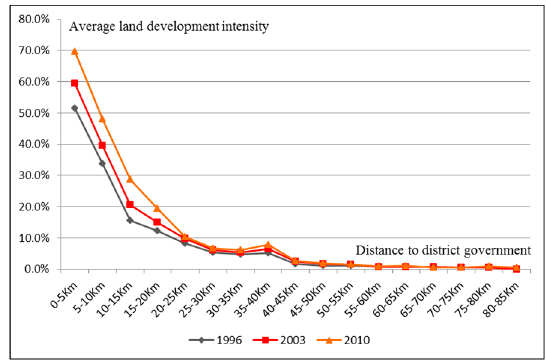
Figure 9. The land development intensity in buffer rings around the distract and county governments.